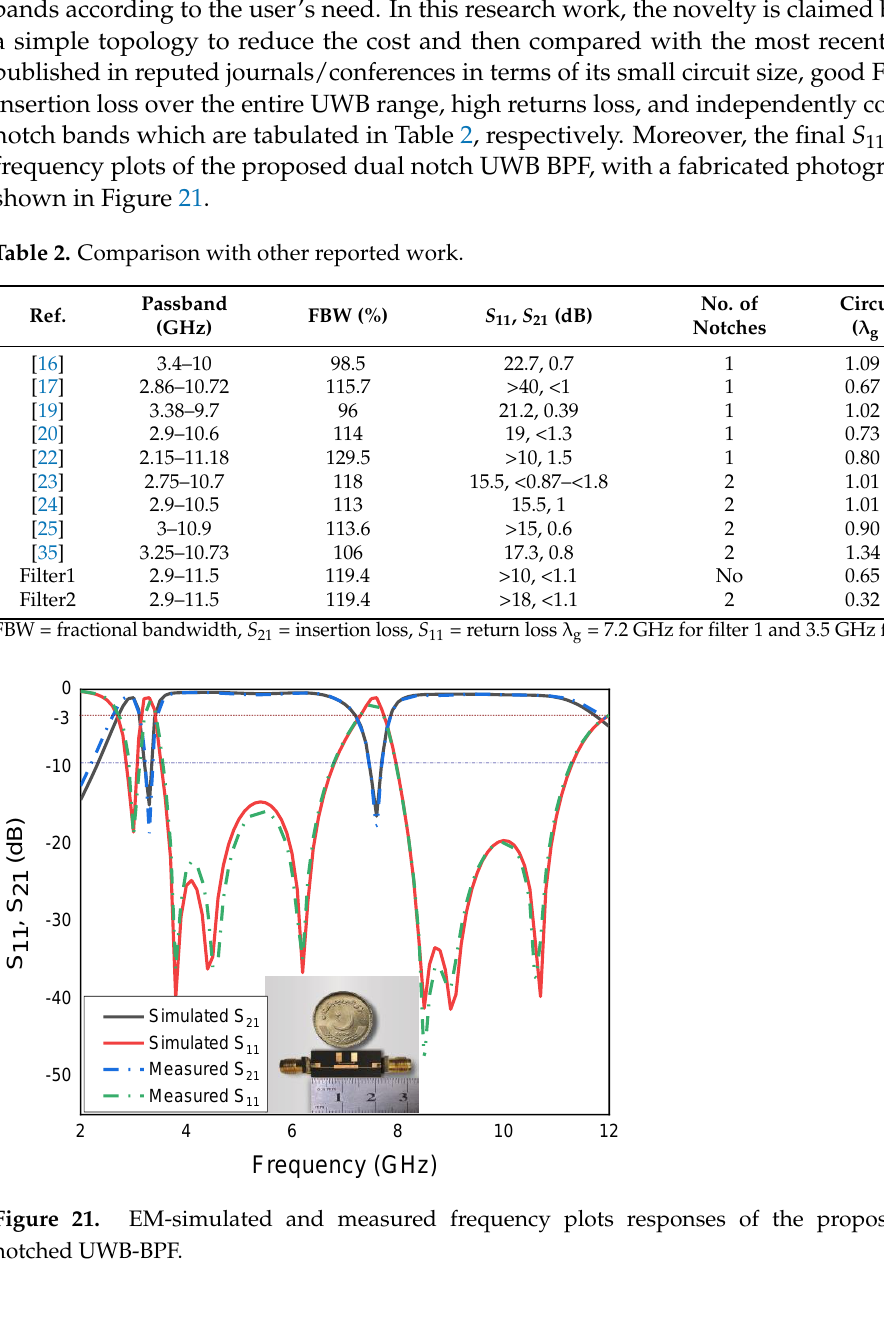
Figure 20. Current distribution of the UWB filter with dual notched band characteristics.